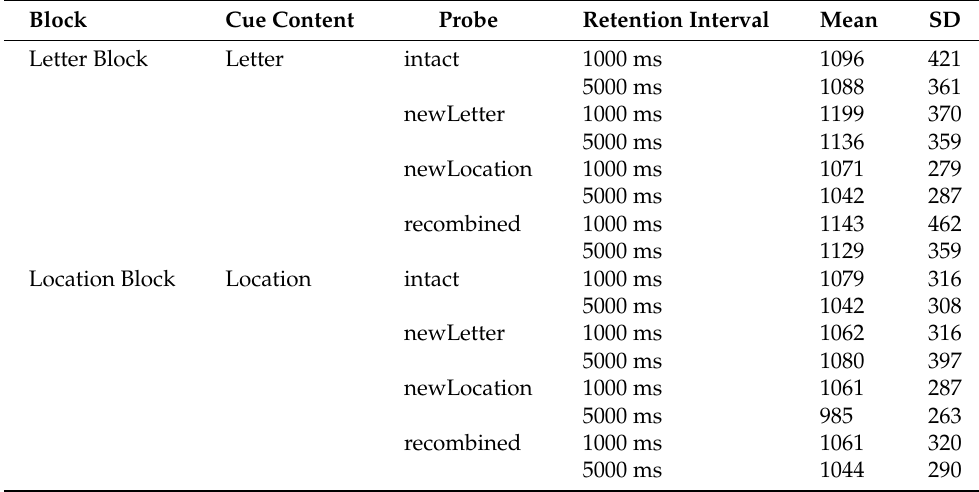
Table 4. Mean trimmed response times (with standard deviations) per cue timing, cue content, probe type and set size, Experiment